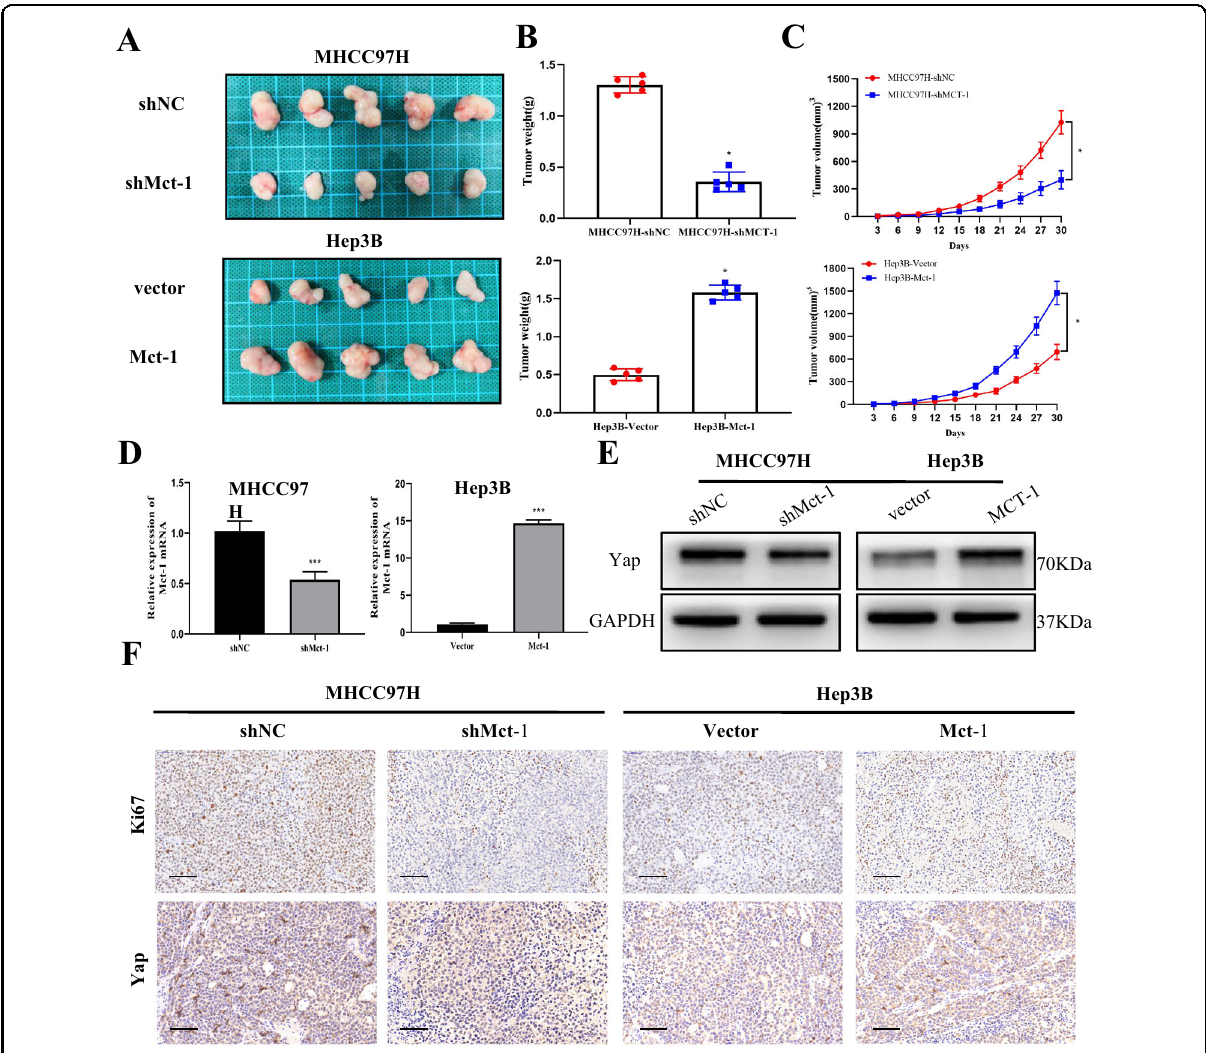
Fig. 8 Mct-1 promotes HCC progression in vivo. A – C Representative photographs of tumors derived from lentivirus-mediated Mct-1-silenced MHCC97H cells and Mct-1-overexpressing Hep3B cells. The tumor volume and weight were measured. D The Mct-1 expression levels of the xenografts were analyzed by qRT-PCR. E Yap expression levels of xenografts were detected by western blot analysis. F Representative immunostaining images of the Ki-67 and Yap expression levels in xenografts. Scale bar = 50 µm. The data are presented as the mean ± SD of experiments performed in triplicate. * p < 0.05, ** p < 0.01, *** p <